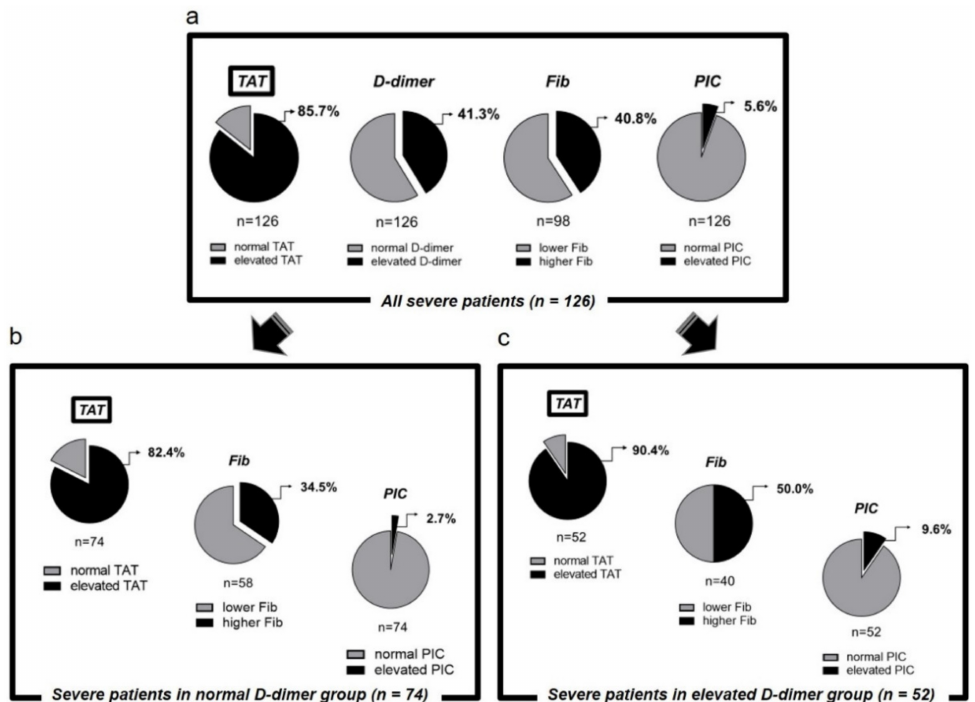
Figure 2. Percentage of patients in the severe group with abnormal coagulation/fibrinolytic markers. Higher fibrinogen was defined as fibrinogen ≥ 617 mg/dL, elevated D-dimer as D-dimer ≥ 1.0 µ g/mL, elevated TAT as TAT ≥ 4.0 ng/mL, and elevated PIC as PIC > 0.8 µ g/mL. TAT, thrombin-antithrombin complex; PIC, plasmin-alpha2-plasmin inhibitor-complex. ( a ) All severe patients. ( b ) Severe patients in normal D-dimer group. ( c ) Severe patients in elevated D-dimer group.